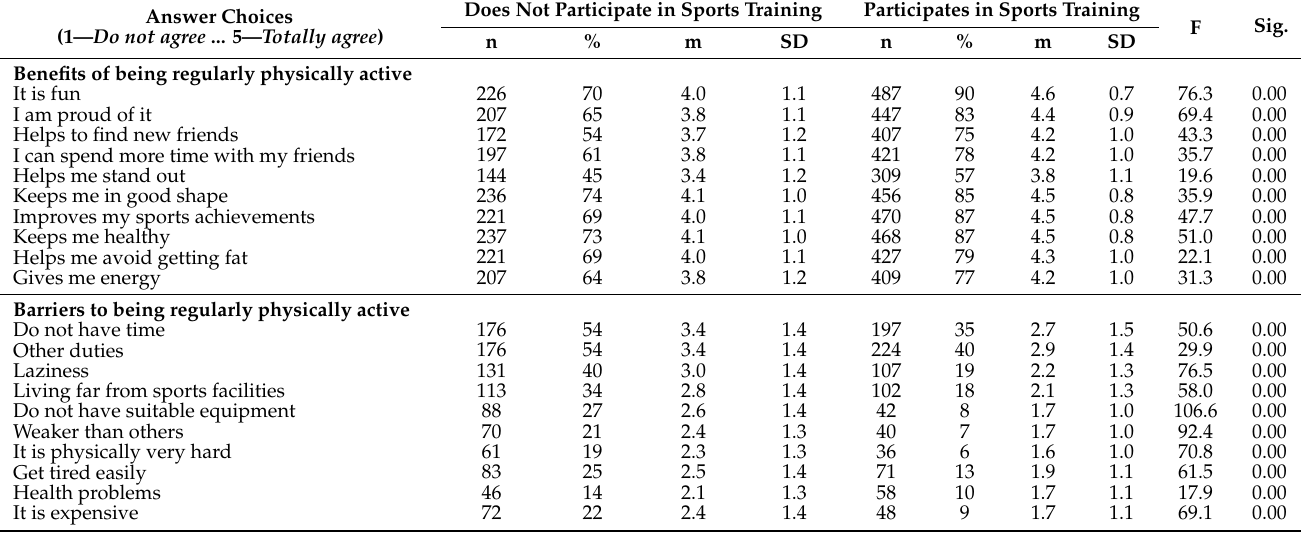
Table 6. Adolescents’ perceived benefits and barriers to physical activity (m ± SD) according to their participation in organised sports training. Statistical significance was calculated by using analysis of